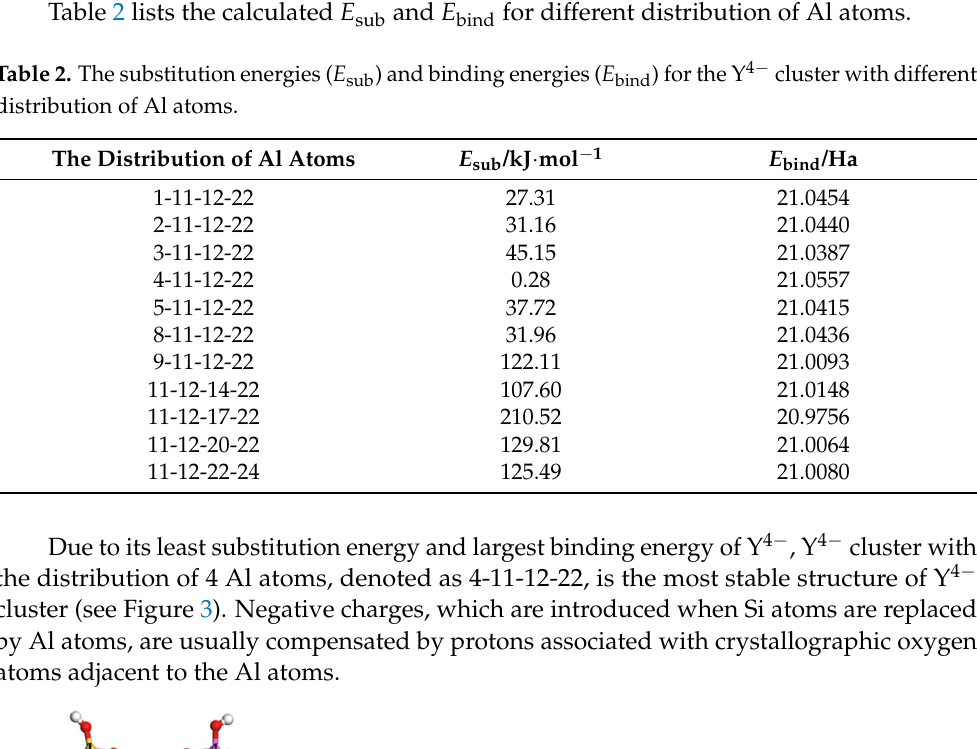
Figure 4. The stable cluster geometries of ( a ) Cu 2+ Y, ( b ) Cu + Y, ( c ) Cu 2 O-Y and ( d ) CuO-Y zeolites. Red, yellow, pink, white and orange balls stand for O, Si, Al, H and Cu atoms, respectively. 3. Discussion In this section, the notation (X)* and (X)(Y)* are referred to active center Cu states, such as Cu + , Cu 2+ , Cu 2 O and CuO interacting with species X and X and Y, respectively. The optimized geometries of reactants, transition states and products for different reaction pathways of DMC formation were calculated. 3.1. The Desorption and Dissociation of CH 3 OH The processes of desorption and dissociation of CH 3 OH on these four types of zeo- lites and the corresponding transition states TS1 are shown in Error! Reference source not found. .